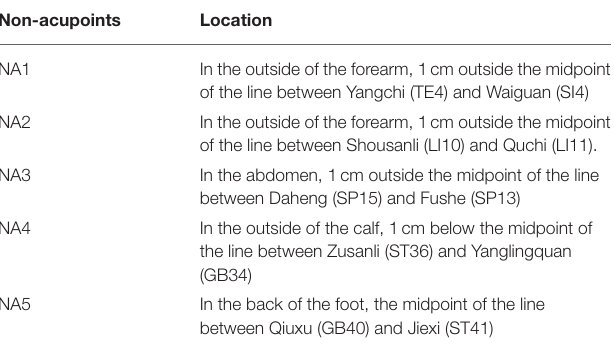
TABLE 1 | Location of non-acupoints in minimal acupuncture group.